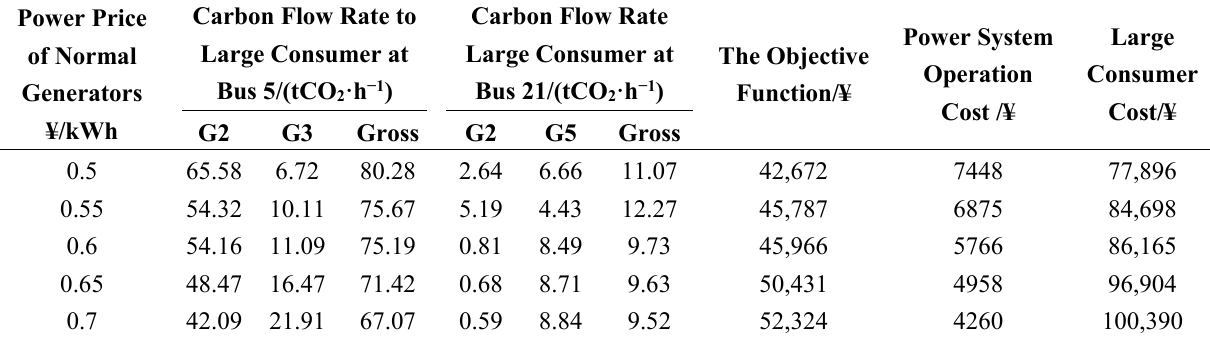
Table 9. Results under the condition of different electricity prices of the normal